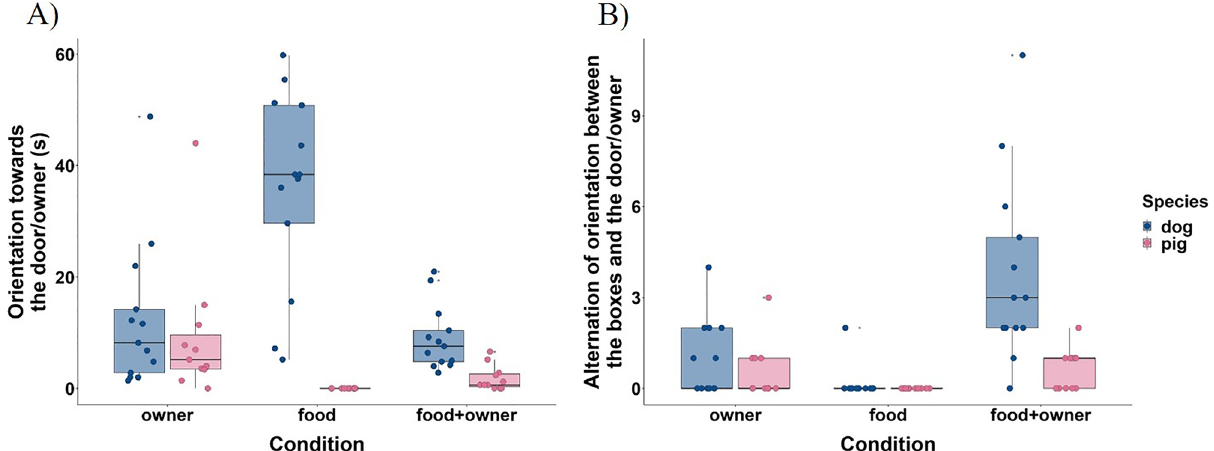
Figure 3. Time spent orienting towards the door/owner ( A ) and frequency of alternation of orientation ( B ) for both species. Boxplots indicate the median, 25th and 75th percentiles (boxes), and the minimum and maximum (whiskers). Dots represent individual data